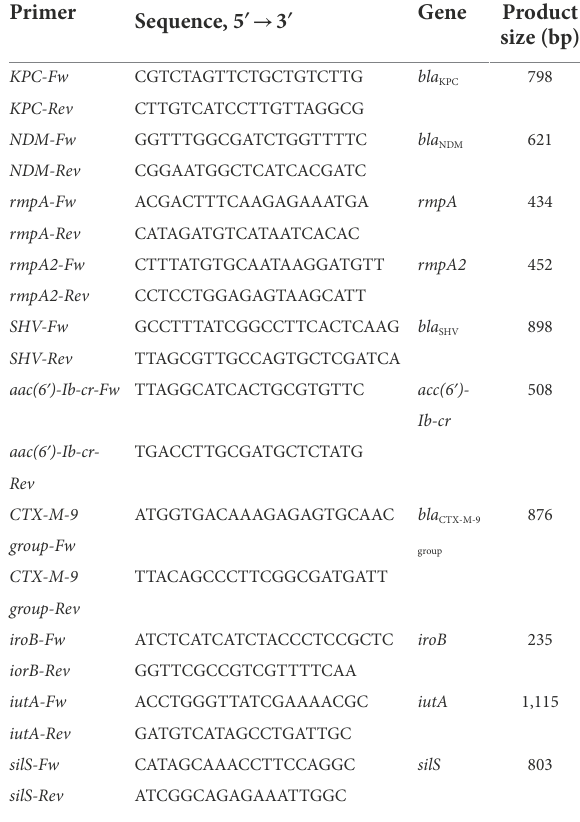
TABLE 1 Sequences of